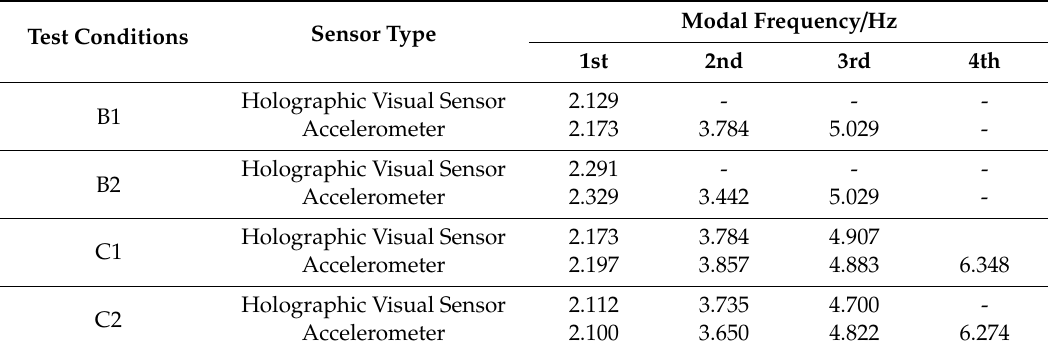
Table 3. Data comparison of HVS and the sensor in dynamic